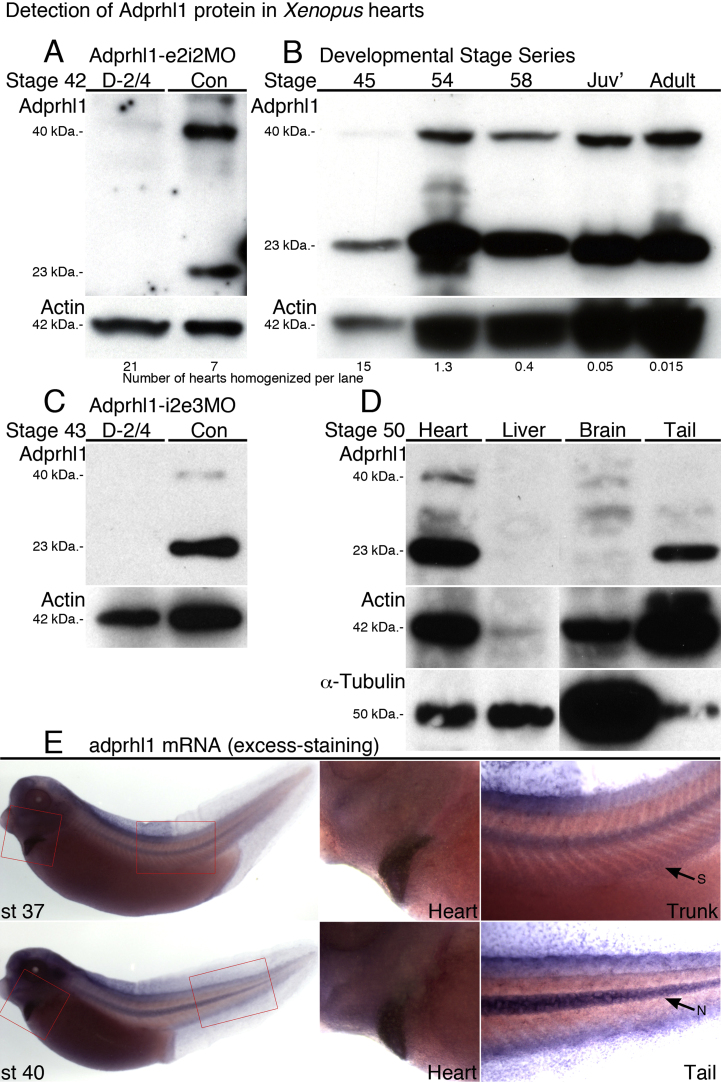
Detectionof Adprhl1 protein in Xenopus hearts and absence in morpholino injected embryos. A: Western blot detection of Adprhl1 protein in stage 42 hearts and its absence after injection of Adprhl1-e2i2MO into D-2/4 blastomeres. 21 of the small, morphant hearts were harvested compared to 7 controls, while detection of actin was used to normalize the samples. Two Adprhl1 protein bands, 40 and 23 kDa, were identified in control hearts, only. B: Developmental stage series showing the reversed, relative abundance of the two Adprhl1 protein species in older hearts. C: Injection of the second, Adprhl1-i2e3MO produced a similar loss of Adprhl1 protein. D: Adprhl1 detection within embryonic tissues showed the 40 kDa protein was heart-specific whereas the 23 kDa species was also found in dissected tail pieces. E: Tadpoles excessively stained for adprhl1 mRNA gave a signal in somite (S) and notochord (N) tissue, suggesting a possible tail source for the 23 kDa protein (29 h substrate incubation instead of the typical 2–4 h).